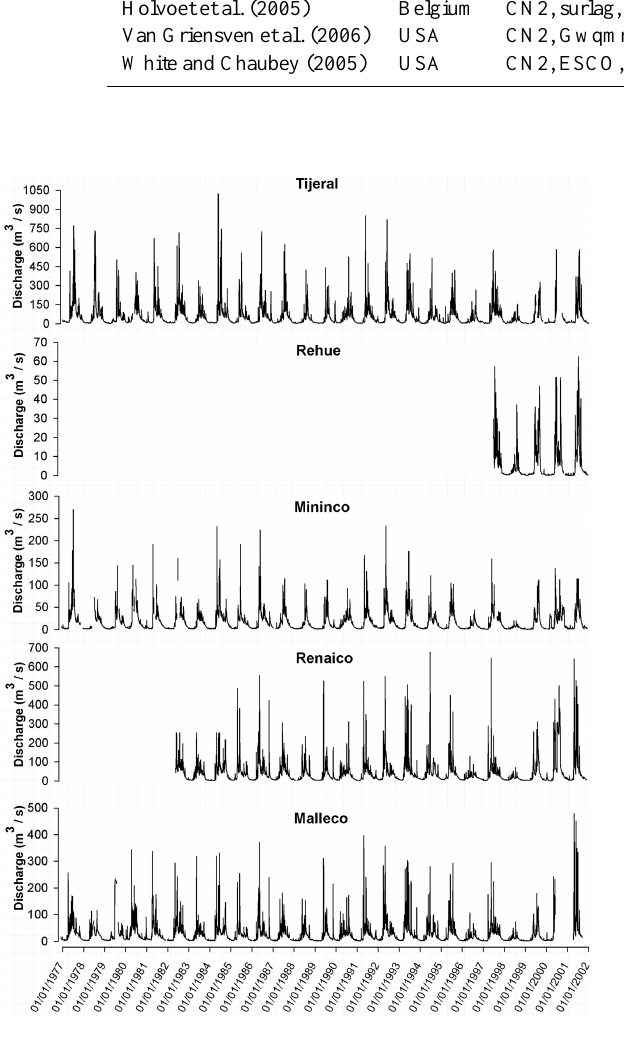
Fig. 7. Hydrographs based on daily mean discharges for the pe- riod 1977–2002 recorded at Tijeral, Rehue, Mininco, Renaico, and Malleco gaugin